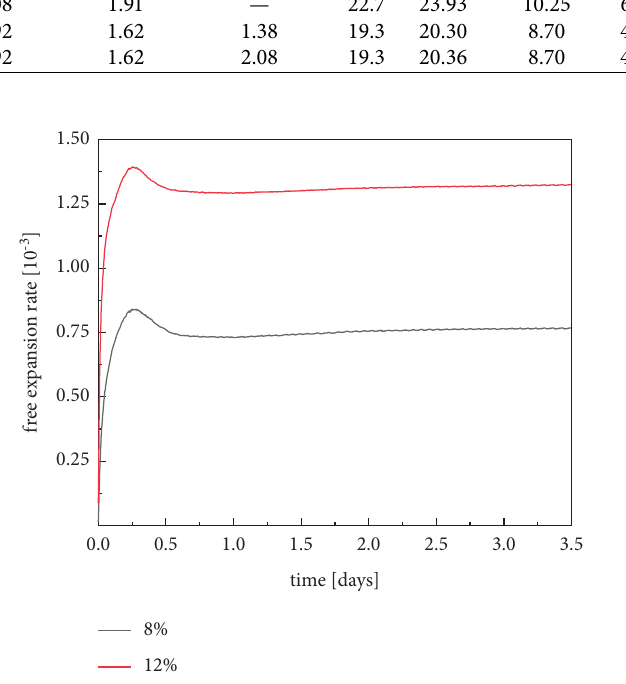
Figure 3: Free expansion-age curve.